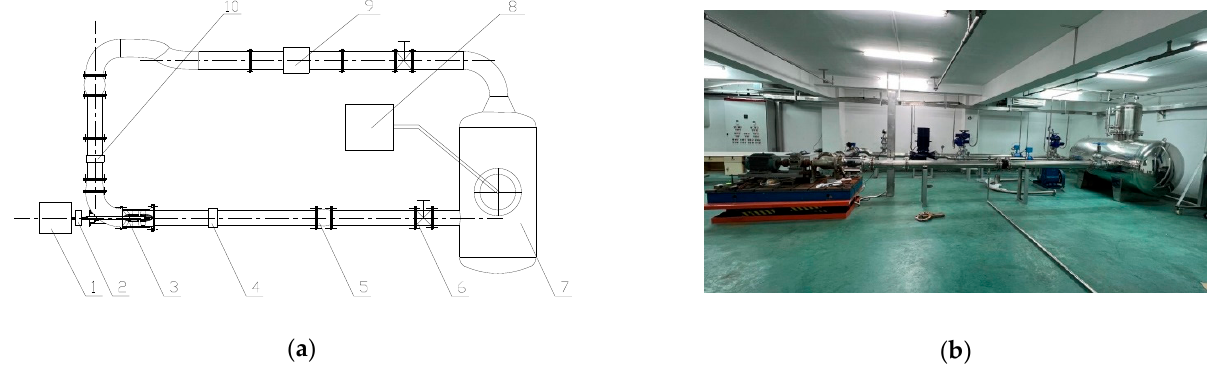
Figure 5. Model pump experiment bench. ( a ) Schematic diagram of experiment bench. 1. Frequency conversion motor; 2. torque measuring instrument; 3. axial flow pump test section; 4. inlet pressure measuring section; 5. telescopic rubber hose; 6. watergate valves; 7. water tank; 8. vacuum pump; 9. electromagnetic flowmeter; 10. outlet pressure measuring section. ( b ) Picture of real